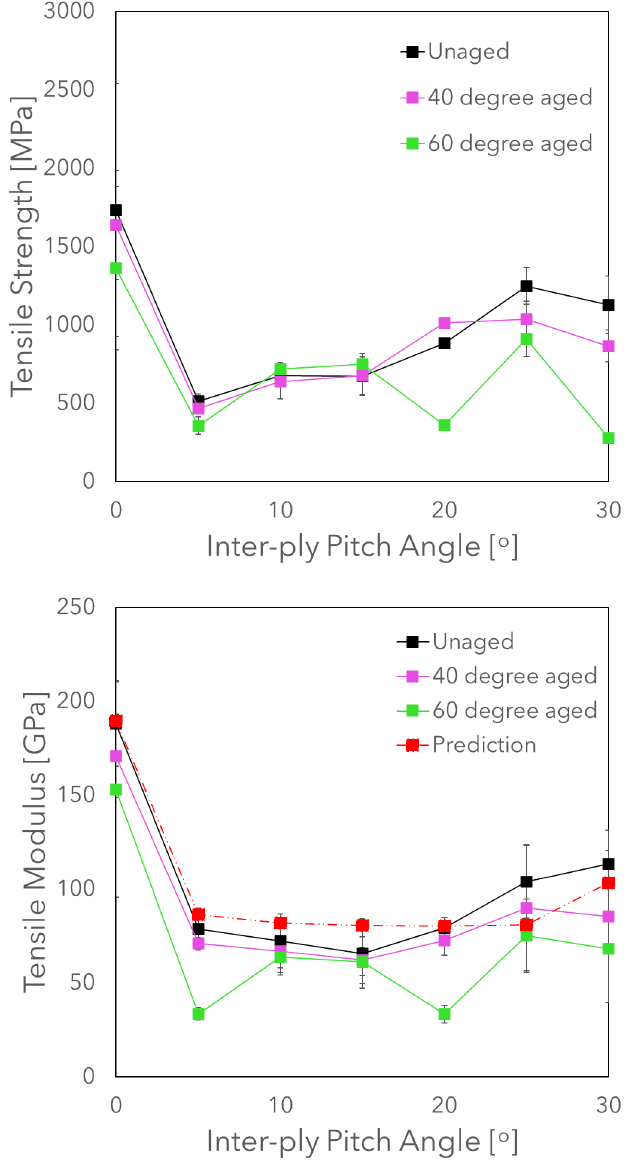
Figure 3. Mean values of tensile strength and tensile modulus, for all sample sets ( n = 5 for each sample set), plotted as a function of the inter-ply pitch angle. Standard deviations about the mean are shown by y-error